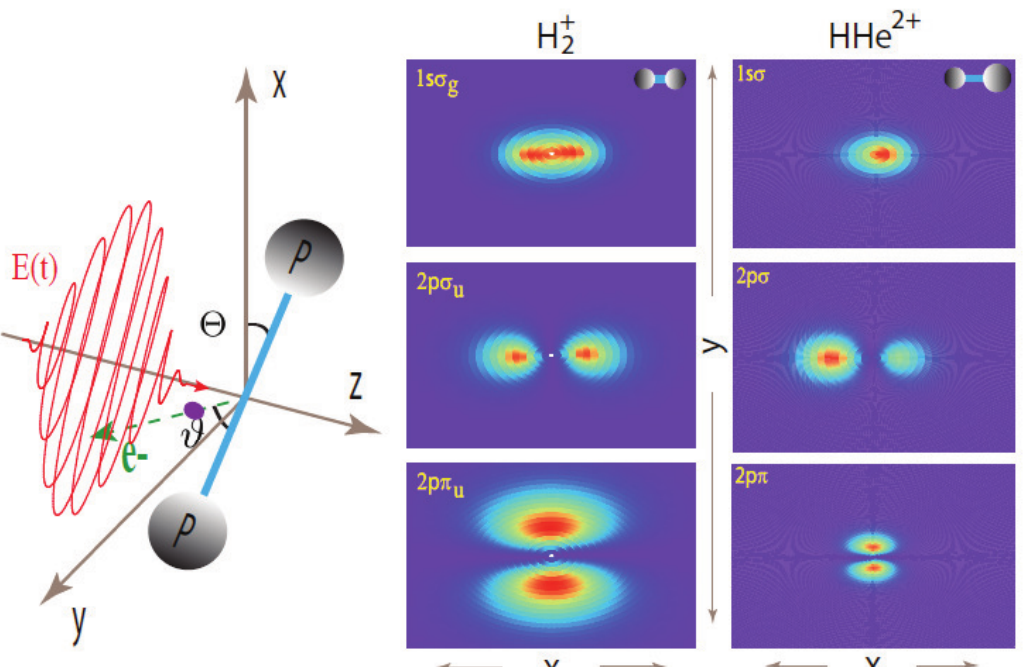
Figure 1. Left column: Schematic illustration of the photoionization process in an oriented molecular ion by circularly polarized attosecond XUV laser pulses propagating along the z axis, perpendicular to the ( x, y ) plane. Θ is the orientation angle between the molecular internuclear R axis and the x axis, and the green dashed line ( e- ) indicates the direction of the photoelectron with an ejected angle ϑ with respect to the molecular internuclear R axis in the molecular and laser polarization ( x, y ) plane. 3D plots of initial wavefunction densities for the three lowest electronic states of the x oriented ( Θ = 0 ◦ ) molecular ions at R = 2 a.u.: 1 sσ (middle column) the H + , 2 pσ , and 2 pπ states, and (right column) the HHe 2+ 1 sσ , g u u 2 2 pσ , and 2 pπ states. Adapted from